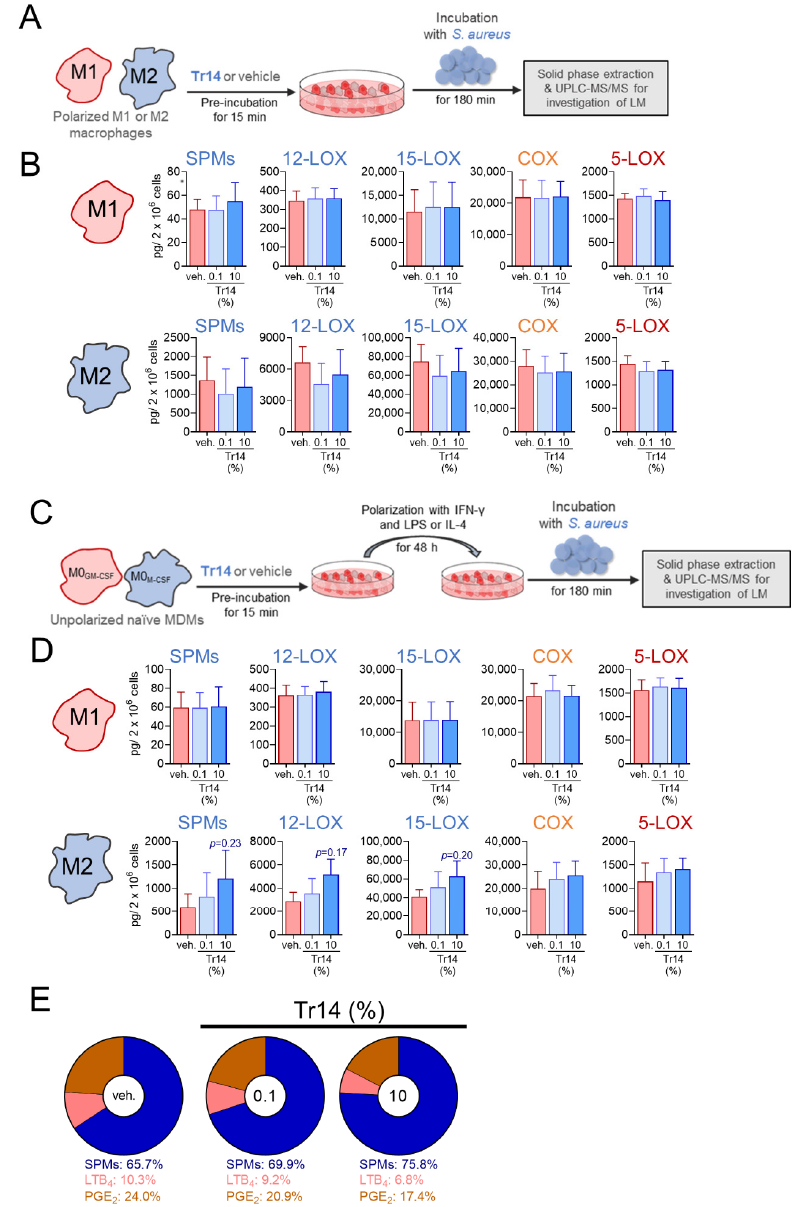
Figure 4. High dose Tr14 increases 15-LOX-1-mediated lipid mediator biosynthesis in human M2 MDM. ( A ) Scheme of administration of Tr14 to polarized macrophages prior incubation with S. aureus . ( B ) Human M1- and M2-MDM (2 × 10 6 cells/mL) were preincubated in PBS pH 7.4 containing 1 mM CaCl 2 with 0.1 or 10% of Tr14 or vehicle (veh., 0.9% NaCl solution) for 15 min at 37 ◦ C and then incubated with S. aureus (LS1; ratio 1:50) for another 180 min. Formed LM were extracted from the supernatants and analyzed by UPLC-MS-MS and are given as means + SEM; n = 3 separate donors. ( C ) Scheme of administration of Tr14 to macrophages prior to polarization. ( D ) Human macrophages (M0) were preincubated with 0.1 or 10% of Tr14 or vehicle (0.9% NaCl solution) for 15 min and then polarized for 48 h with LPS/IFN- γ to M1- or with IL-4 towards M2-MDM. Then, cells were incubated with S. aureus (LS1; ratio 1:50) in PBS pH 7.4 containing 1 mM CaCl 2 for another 180 min. Formed LM were extracted from the supernatants and analyzed by UPLC-MS-MS and are given as means + SEM; n = 3 separate donors. Statistical analysis was performed using matched one-way ANOVA with Dunnett ´ s multiple comparison test; relevant p values are given in the figure. ( E ) Amounts of PGE 2 (orange), LTB 4 (red) and SPMs (blue) formed in the M2-MDM that had been treated with vehicle, 0.1 or 10% Tr14 prior polarization (panel D ) are shown in pie charts; data are given as %, n =